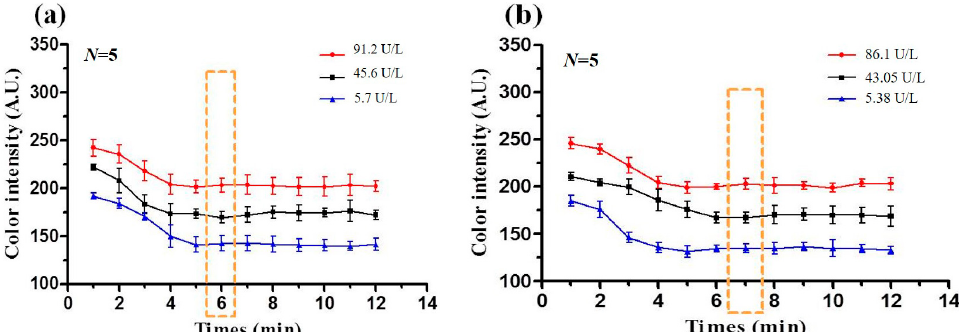
Figure 6. ( a ) Change in mean R+G+B intensity value over time for three AST concentrations (5.7 U/L, 45.6 U/L and 91.2 U/L); ( b ) Change in mean R + G + B intensity value over time for three ALT concentrations (5.38 U/L, 43.05 U/L, and 86.1 U/L). Note that dotted lines indicate the optimal reaction time in each case.